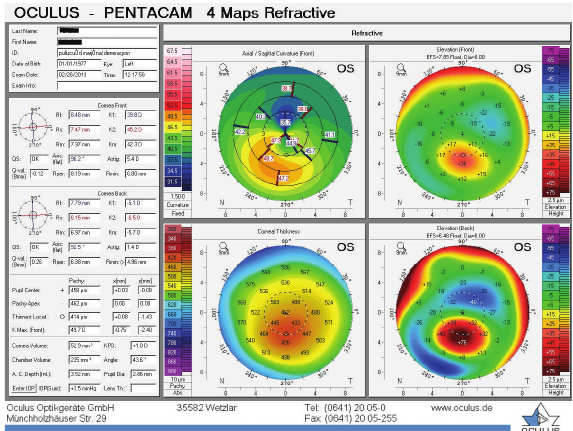
Figure 8: Patient 2, left eye at the last